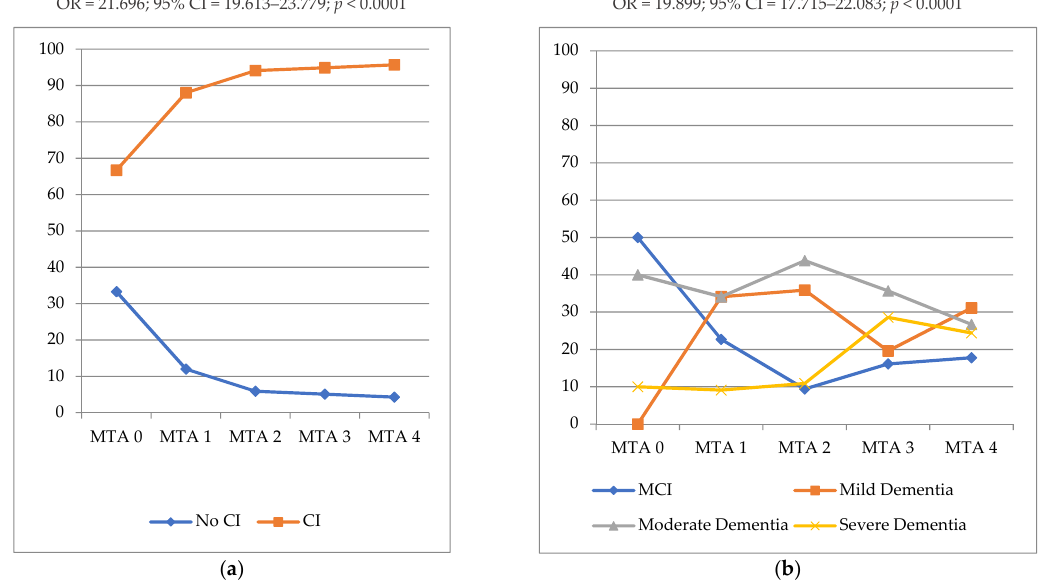
Figure 2. Distribution of MTA score according to the cognitive impairment presence/absence ( a ) and severity ( b ). Legend: MTA , Medial Temporal Lobe Atrophy; NoCI , No Cognitive Impairment; CI , Cognitive Impairment; MCI , Mild Cognitive Impairment; % , percentage of cognitive impairment presence/absence ( a ) and severity ( b ) distributions. In Figure 3, the MTA severity was directly proportional to increased functional im- pairment severity for ADL (OR = 4.996; 95% CI = 4.537–5.456; p < 0.0001) and IADL (OR =